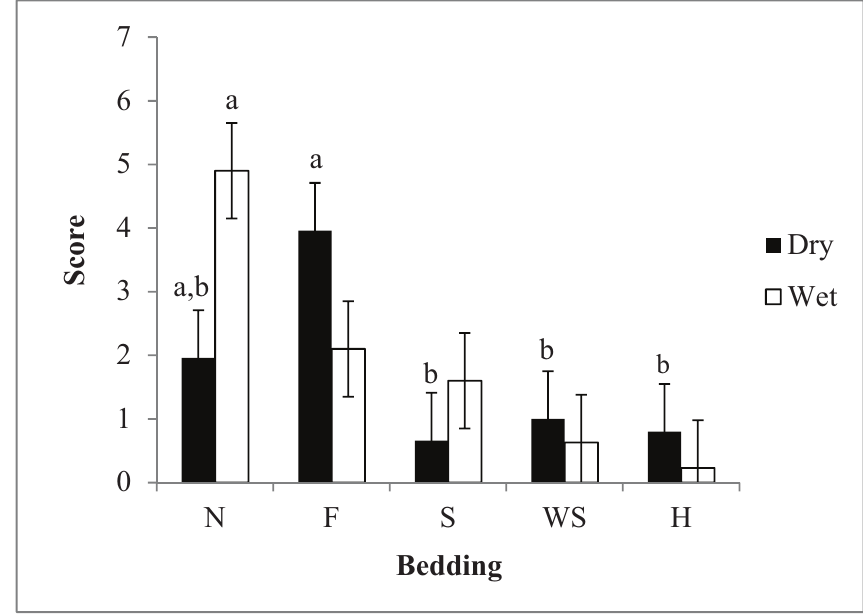
Figure 2. Least Square means ± 0.33 for weaned pig scores with the use of wet or dry bedding materials ( P < 0.05). Beddings abbreviated by N = nothing, F = feed, S = sand, WS = wood shavings, H = hay. Bedding was rated based on a score system which was calculated by the sum of slips, falls, and vocalizations. n = 30 observations/bedding moisture.